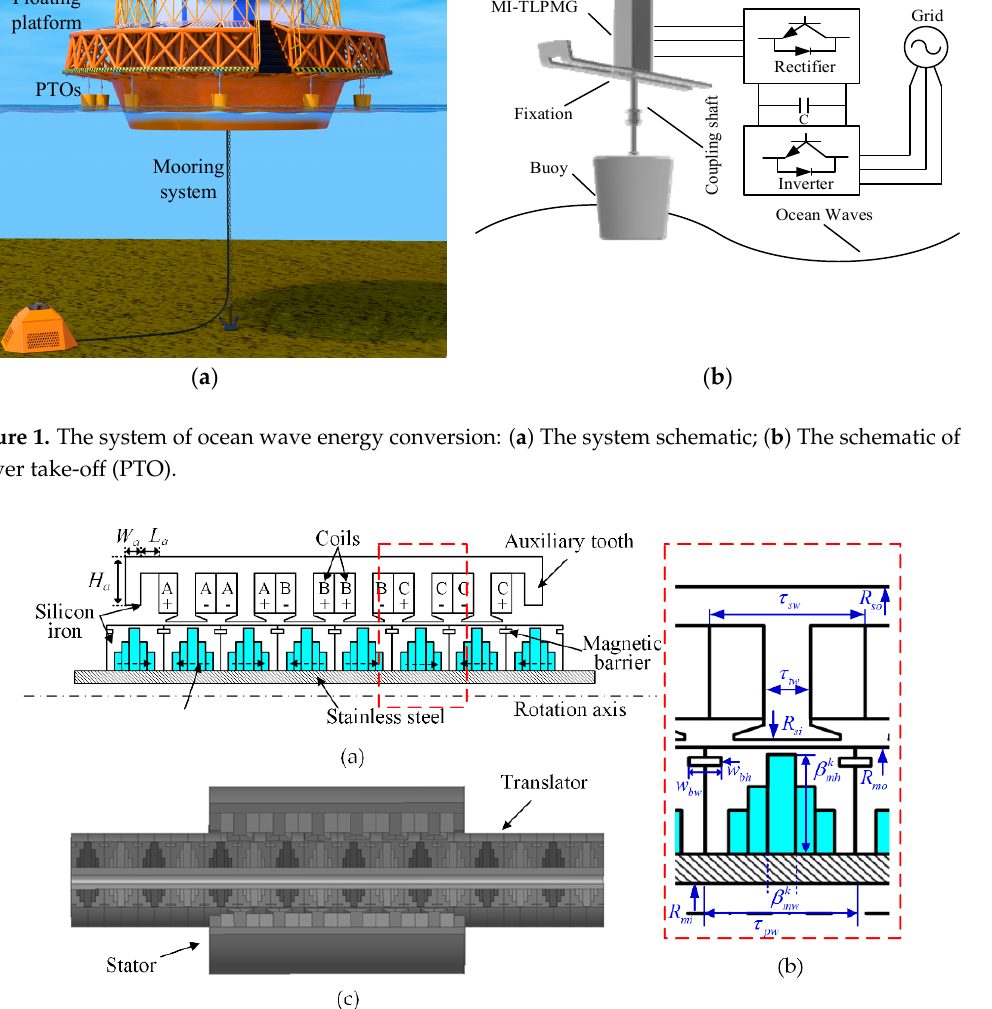
Figure 2. Proposed multilayer interior tubular linear permanent magnet generator (MI-TLPMG) for a wave energy converter (WEC) system: ( a ) cross section schematic; ( b ) key geometric parameters;